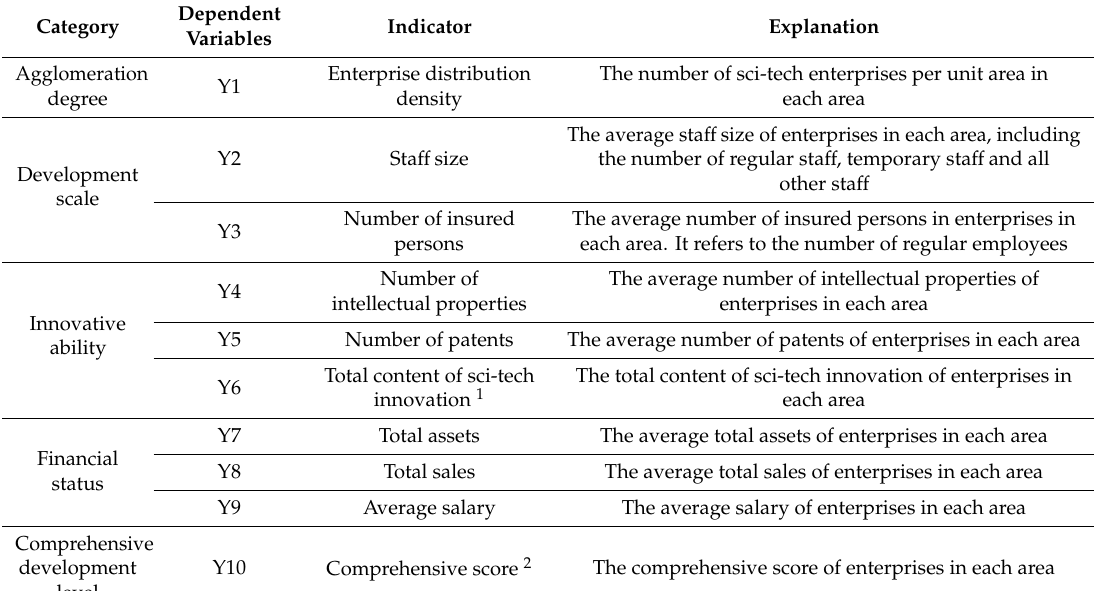
Table 3. List of innovative development indicators of sci-tech park (STP)